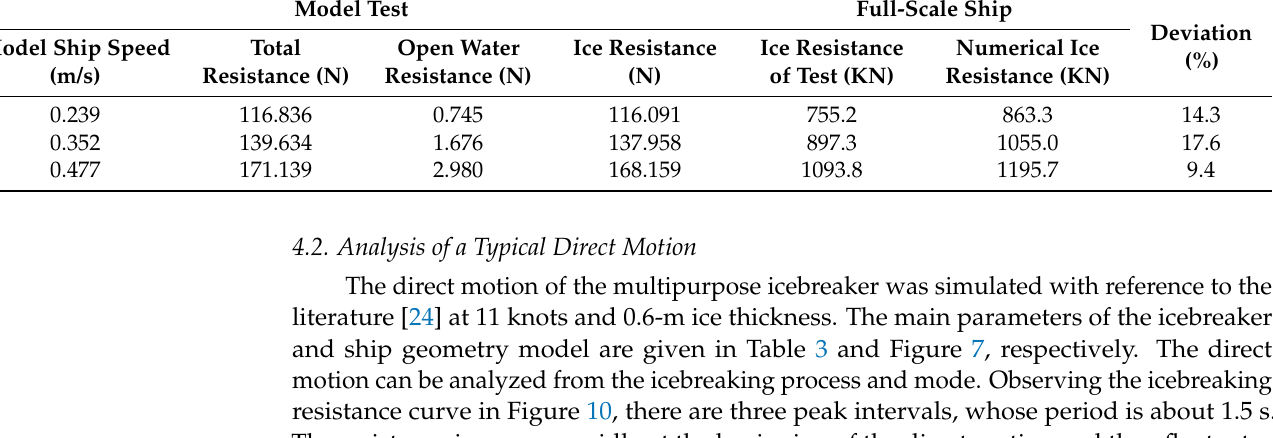
Figure 9. Comparison of numerical results and model test data for the icebreaker Araon . Table 4. Numerical ice resistance and model test ice resistance, and the deviation of speed of each ( λ = 18.667). Model